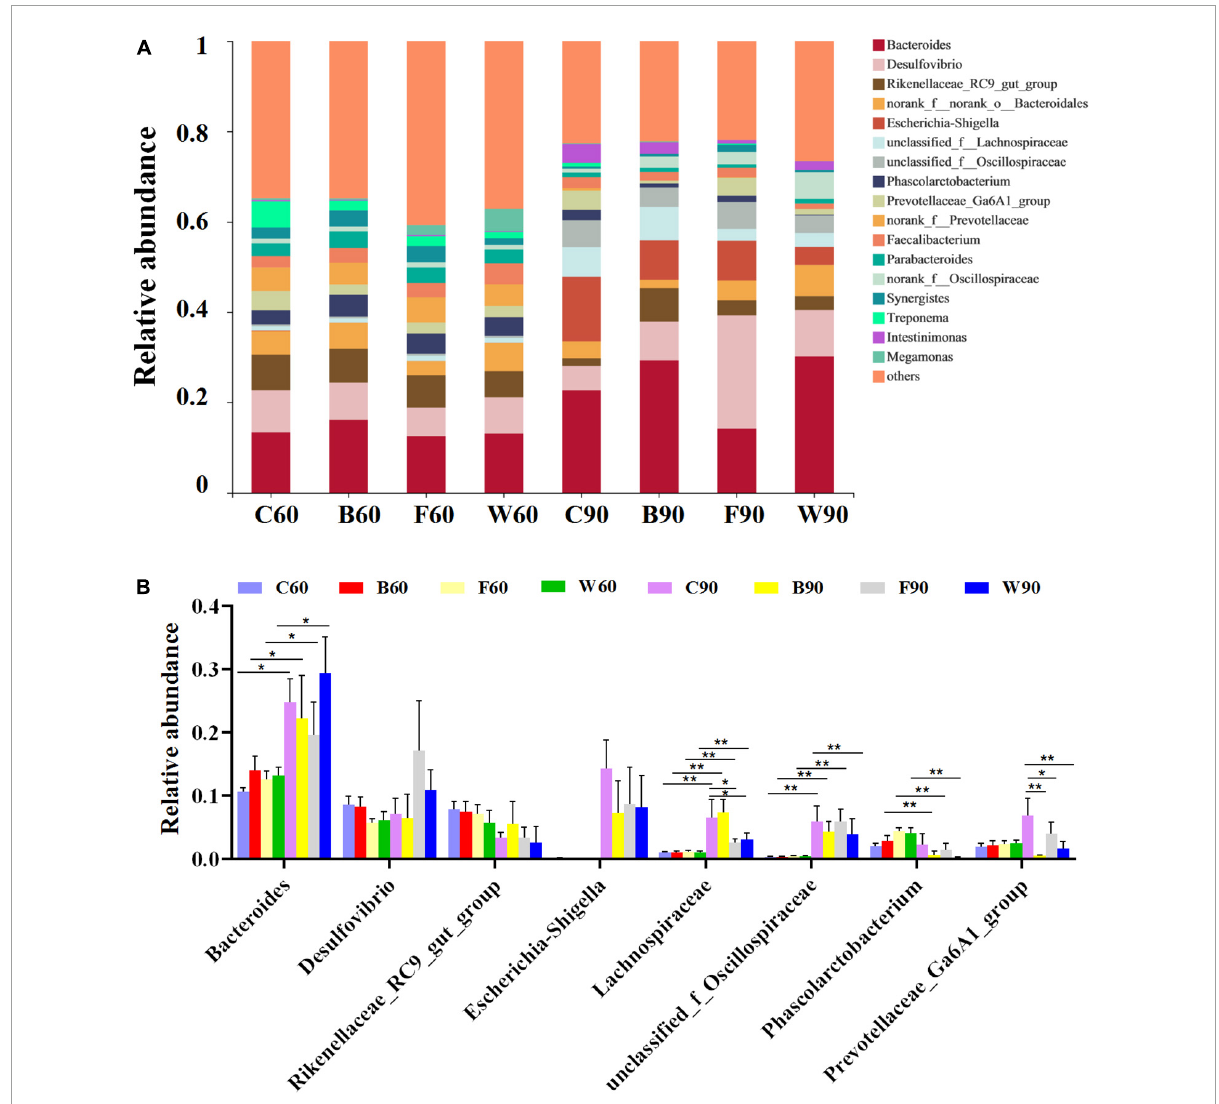
FIGURE3 The microbiome compositions in cecum at the genus level based on the 16S rRNA sequencing in four groups of Landes geese (i.e., groups C, B, F, and W) on both day 60 and 90. (A) The relative abundances of the top 18 bacterial taxa in the microbiome of the Landes geese on day 60 and 90. (B) The relative abundances of the top 18 bacterial taxa in the microbiome of the Landes geese on day 60 and 90 showing the statistical significance. Values are represented as the mean ± stand error of the mean (SEM) ( n = 8 geese per group). The significant difference is set at P < 0.05 (*) and P < 0.01 (**), respectively. Group C, control group; Group B, added with 4% BSG in the overfeeding stage (days 61–90); Group F, added with 4% BSG in the rearing stage (days 5–60); Group W, added with 4% BSG in the all stage (days